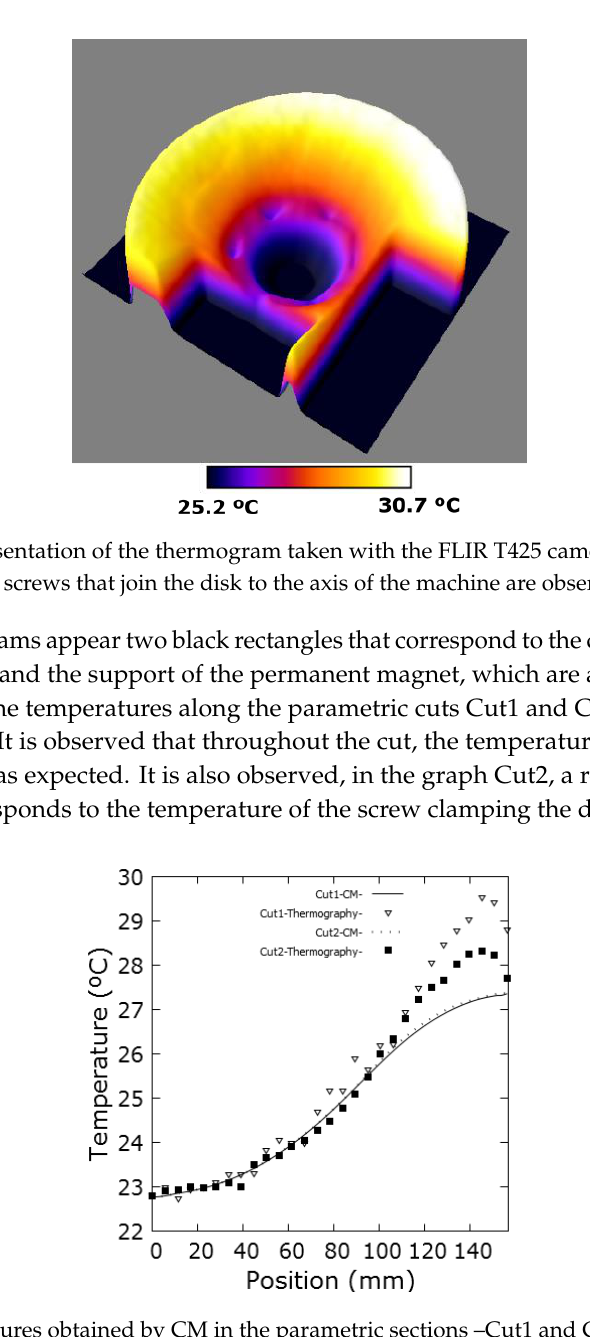
Figure 26. Temperatures obtained by CM in the parametric sections – Cut1 and Cut2 – from the centre of the disk to the periphery, at the instant of 245 s, see Figure 24b. The thermogram has been taken with the FLIR T425 thermal camera and the thermographic data has been obtained with the Fiji image analyser [32], see Figure